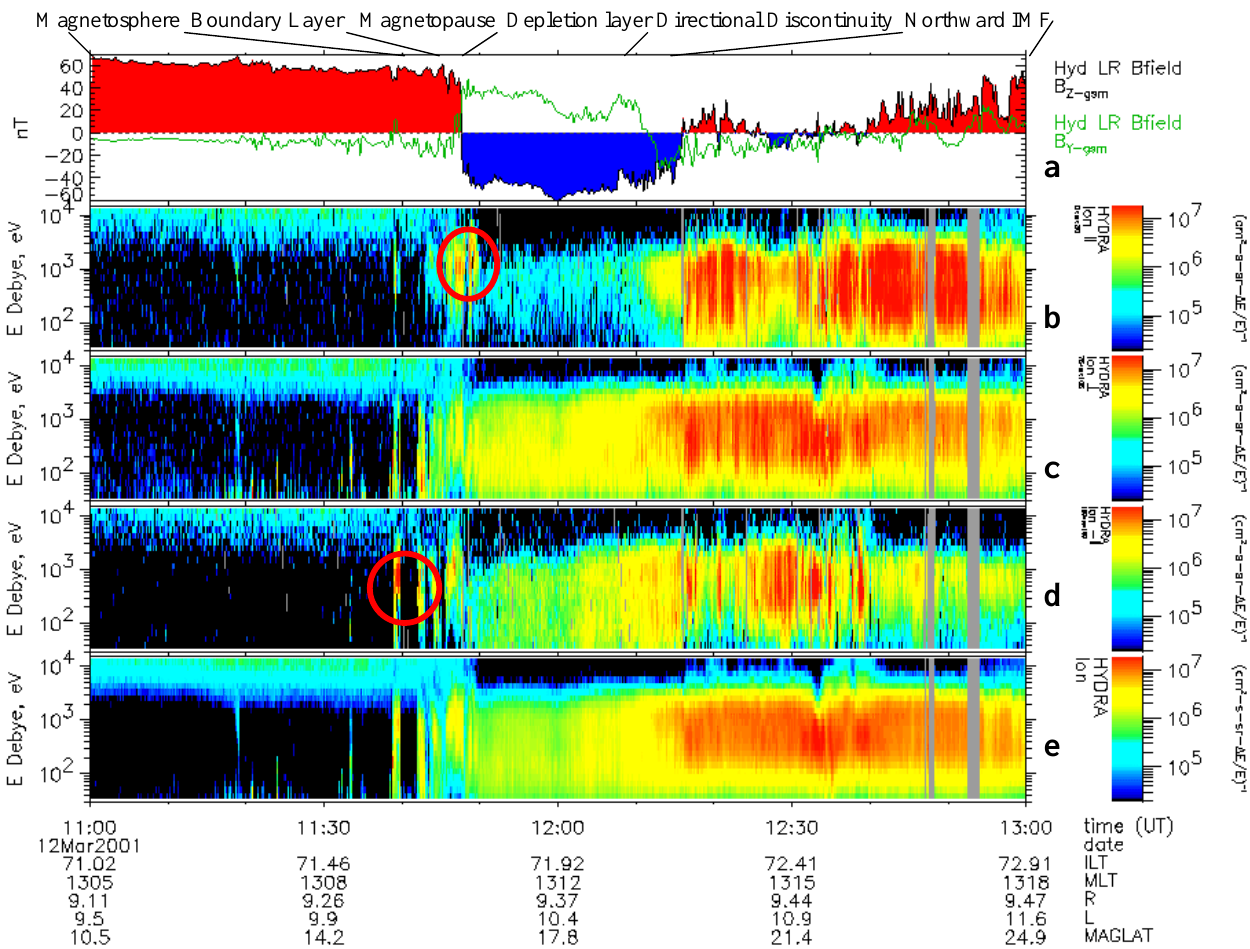
Fig. 6. Ion spectrograms and the magnetic field measured by Polar and plotted for the interval between 11:00 and 13:00 on 12 March 2001. (a) B Z is shaded red (blue) for positive (negative) values. (b)–(e) Parallel, perpendicular, antiparallel and total ion energy spectra measured by the Hydra instrument. The circles highlight parallel or antiparallel accelerated ion fluxes associated with a contact and a crossing of the